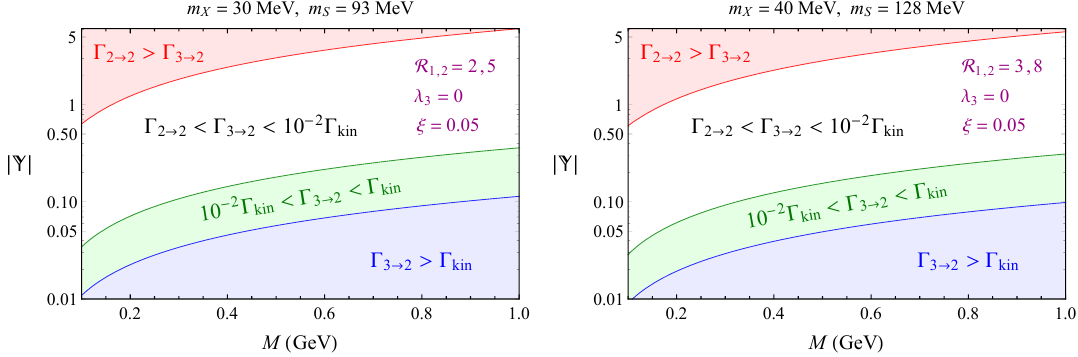
Figure 7 . Magnitude of j Y j versus M for some choices of numerical sets. The white (red) region is the SIMP (WIMP) paradigm, the green region is the allowed parameter space of j Y j by using the weaker SIMP condition, and the blue area is the failure of SIMP